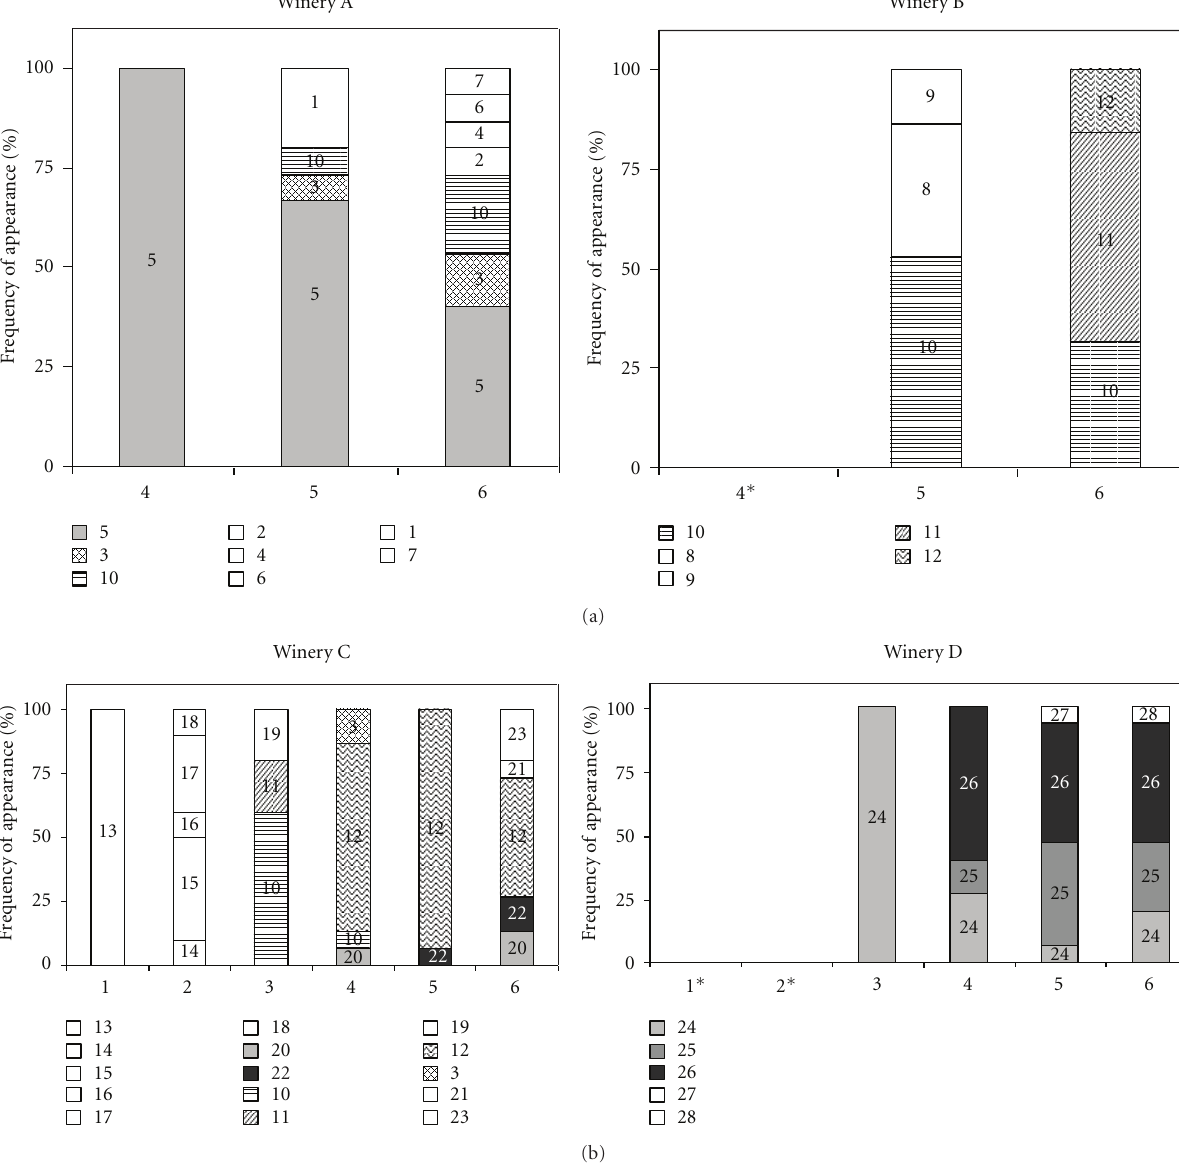
Figure 3: Frequency of appearance (%) of O. oeni genotypes at each sampled stage (1: must; 2: tumultuous AF; 3: final AF; 4: initial MLF; 5: tumultuous MLF; 6: final MLF) in each winery. Empty bars mean genotypes that appeared once, filled bars mean genotypes that appeared in one winery, and textured bars were genotypes detected in more than one winery. ∗ O. oeni was not